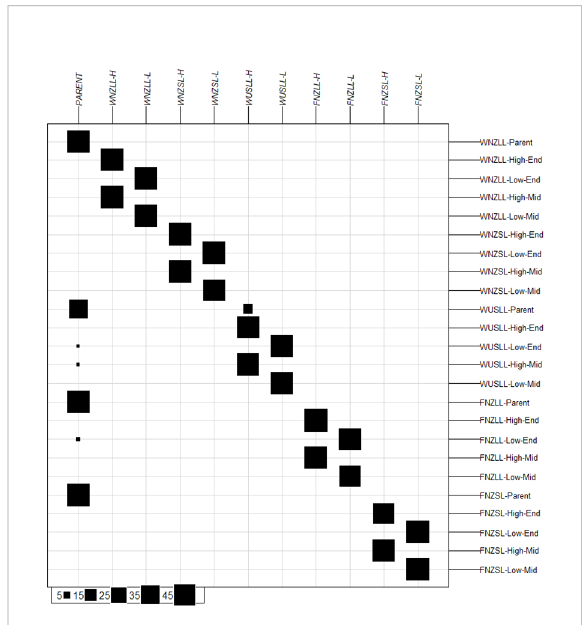
FIGURE 3 Group assignment based on K -means clustering prior to discriminant analysis of principal components for 24 populations. Original populations are positioned horizontally, and K -means determined clusters are positioned vertically. Size of black boxes represent the number of individuals assigned to the K -means determined cluster from the original population, with the scale presented in the bottom left-hand corner. High, high water- soluble carbohydrate (WSC); Low, low WSC; Parent, Parent generation; E, End generation; and M, Middle generation.